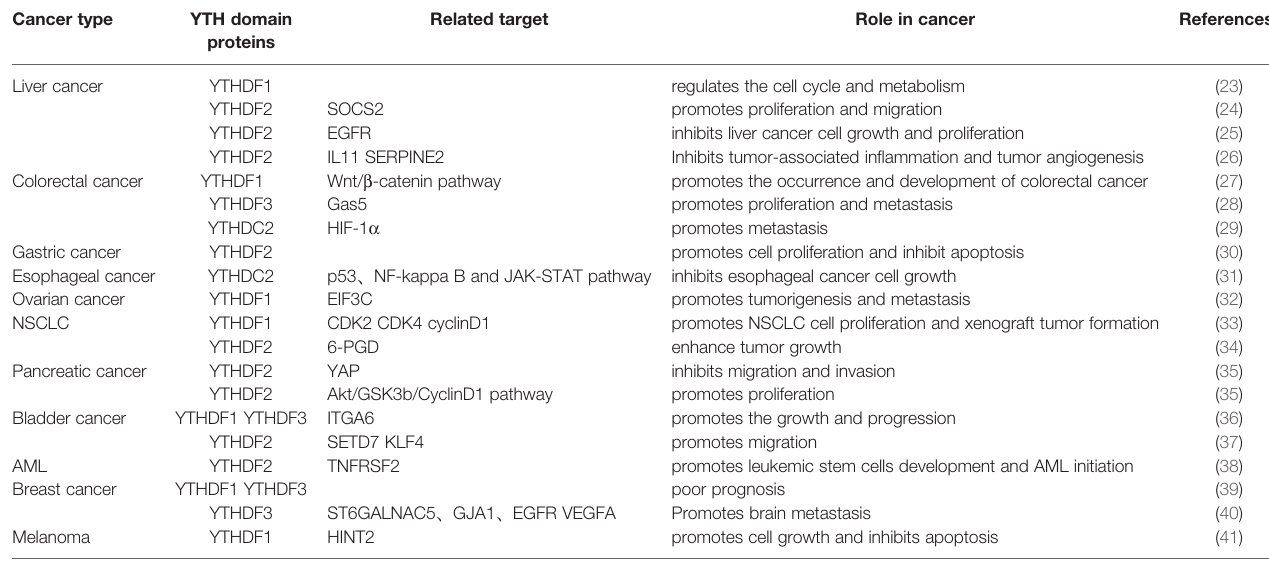
TABLE 1 | Multiple functions exerted by YT521-B homology (YTH) family proteins in various